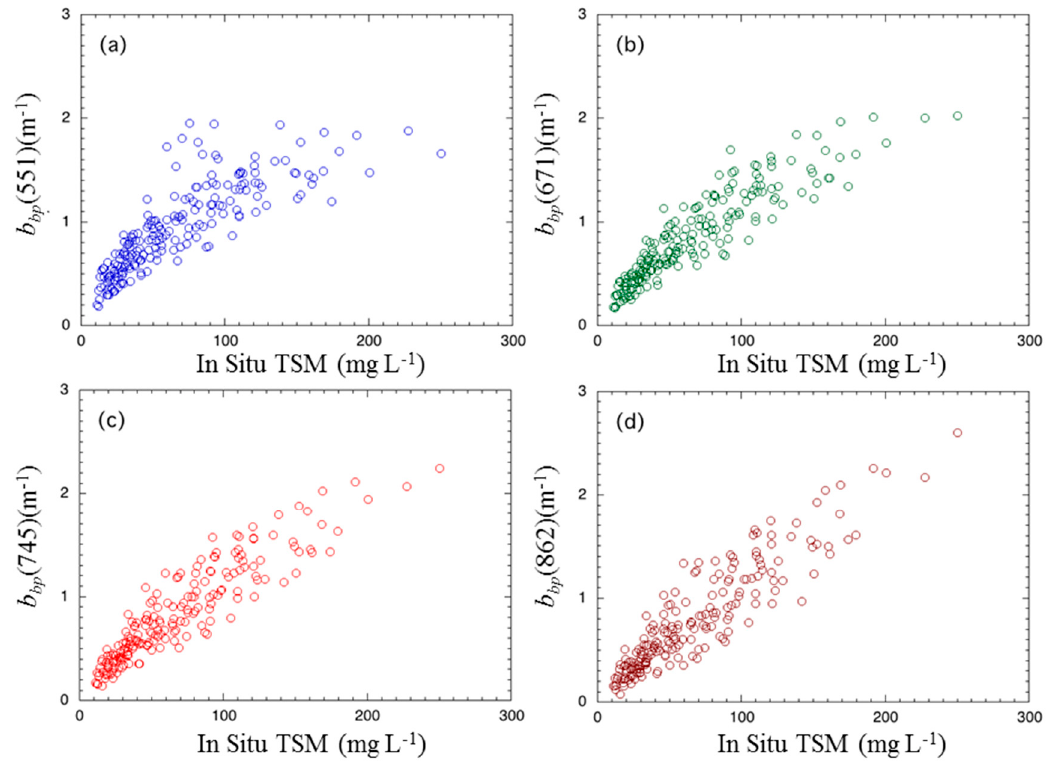
Figure 2. Scatter plots of in situ-derived b bp ( λ ) versus in situ TSM concentration in Lake Taihu for b bp ( λ ) at wavelengths of ( a ) 551 nm, ( b ) 671 nm, ( c ) 745 nm, and ( d ) 862 nm.